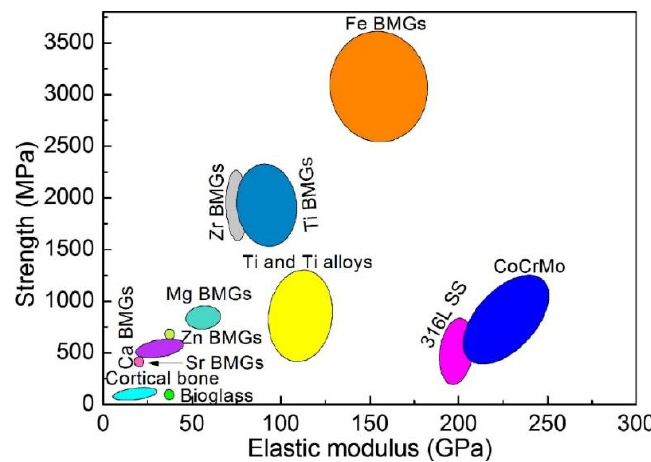
Figure 17. Ashby diagram comparing the mechanical properties of conventional bioglasses, biometals and the novel biomedical BMGs [224]. Reprinted with permission from Elsevier.